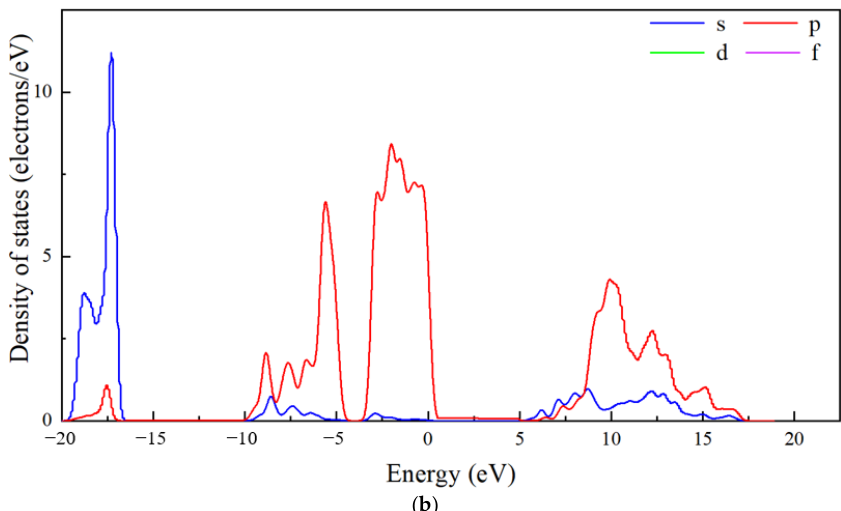
Figure 9. The fractional density of states of calcium oxide and silica: ( a ) fractional density of states of calcium oxide; ( b ) fractional density of states of silicon dioxide.